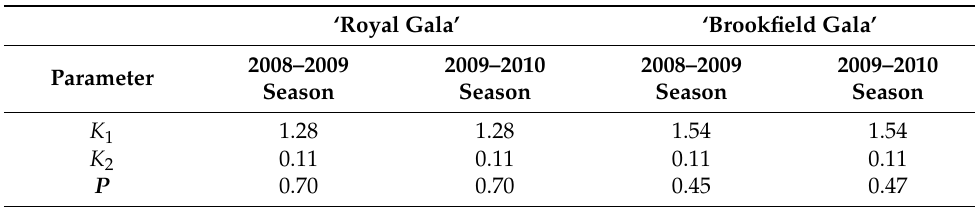
Table 1. Correction factor Fc and parameters K 1 , K 2, and P , for the 2008–2009 and 2009–2010 seasons for ‘Royal Gala’ and ‘Brookfield Gala’ apple trees. ‘Royal Gala’ ‘Brookfield Gala’